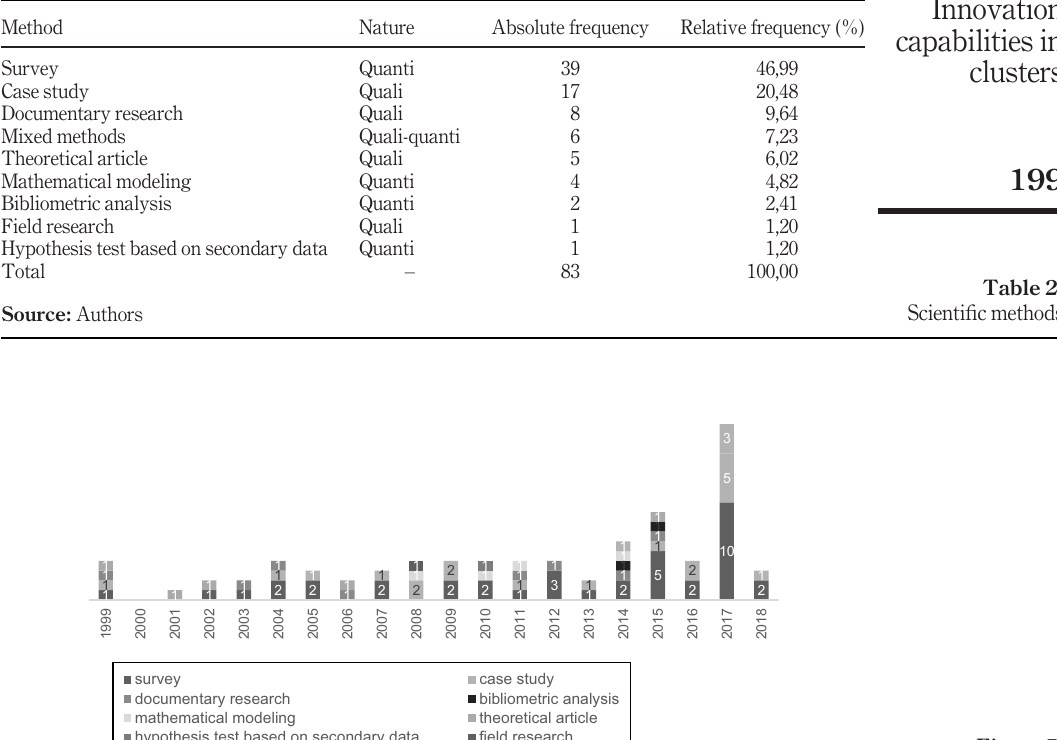
Figure 5. Methods over the